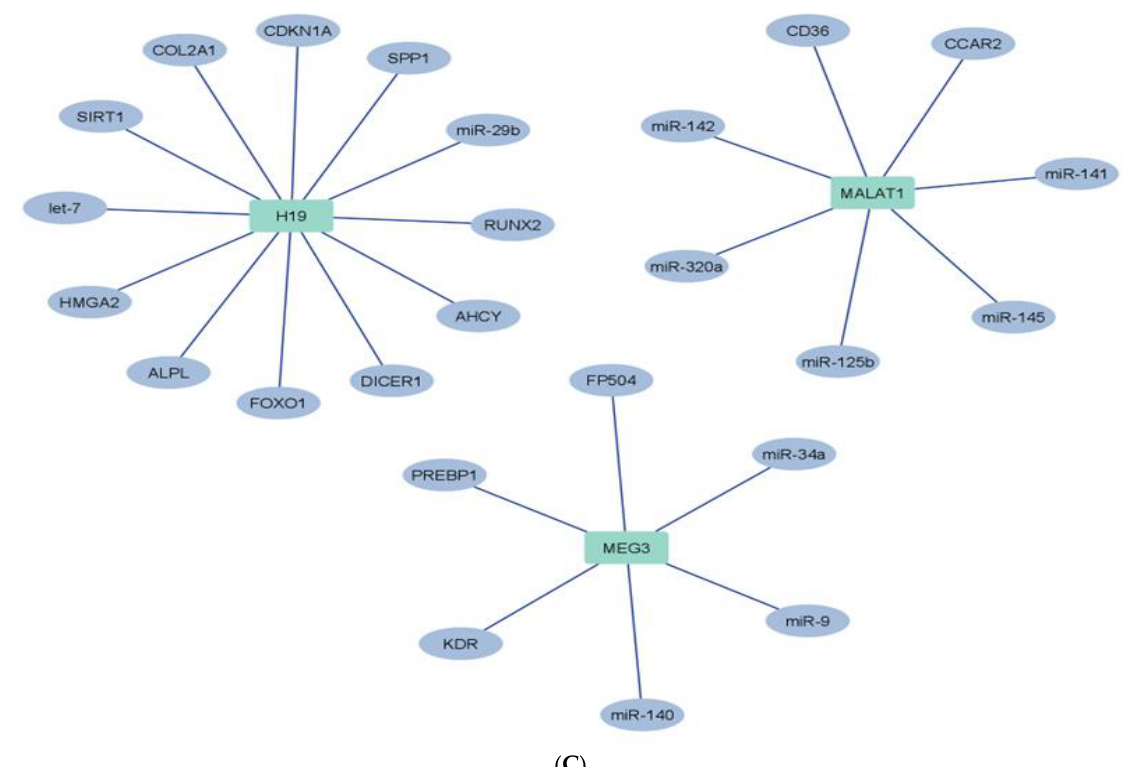
Figure 8. Common dysregulated lncRNA–target networks in diabetes: ( A ) Human upregulated lncRNA–gene target network: Topology of networks of commonly upregulated lncRNAs implicated in diabetes in humans showing interaction network of lncRNAs with their targets, with 15 nodes and 13 edges. The networks were constructed using Cytoscape 3.9.1 [84]. The lncRNA–target interactions were identified by lncRNA2target v3.0 [93] and LncRRIsearch [94]. ( B ) Human downregulated lncRNA–gene target network: Topology of networks of commonly downregulated lncRNAs in diabetes showing interaction network of lncRNAs with their targets, with 28 nodes and 25 edges. The networks were constructed using Cytoscape 3.9.1 [84]. The lncRNA–target interactions were identified by lncRNA2target v3.0 [93] and LncRRIsearch [94]. ( C ) Human upregulated and downregulated lncRNA–gene target network: Topology of networks of commonly upregulated and downregulated lncRNAs in diabetes showing interaction network of lncRNAs with their targets, with 28 nodes and 25 edges. The networks were constructed using Cytoscape 3.9.1 [84]. The lncRNA–target interactions were identified by lncRNA2target v3.0 [93] and LncRRIsearch [94].